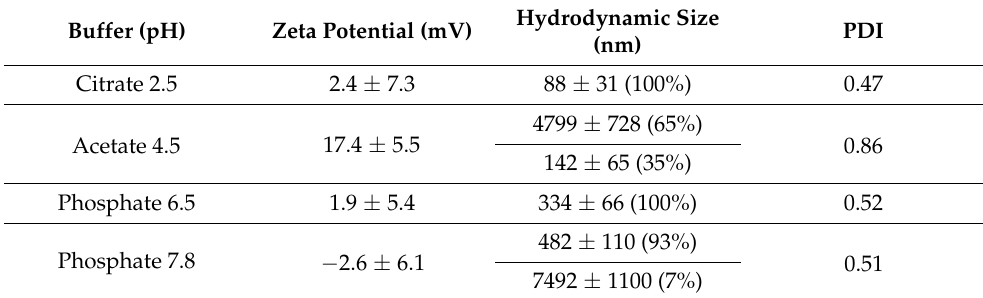
Hydrodynamic Size PDI (nm)